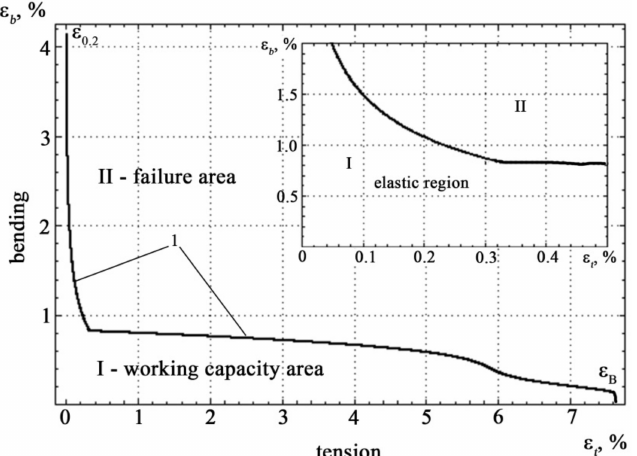
Figure 9. Boundary curve 1 and areas of working capacity and fracture states in the coordinates of relative deformation (the inset shows a portion of the boundary curve corresponding to the elastic deformation